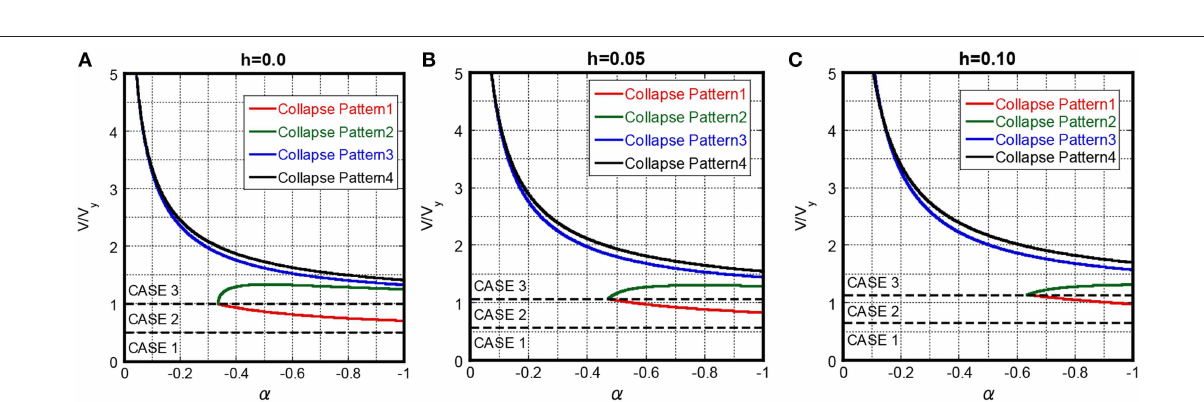
FIGURE 9 | Comparison of proposed collapse-limit input velocity level and minimum collapse-limit input velocity level by time-history response analysis, (A) h (B) h 0.10. =